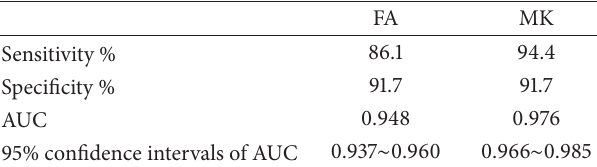
Table 2: ROC analysis of FA and MK for the SN.